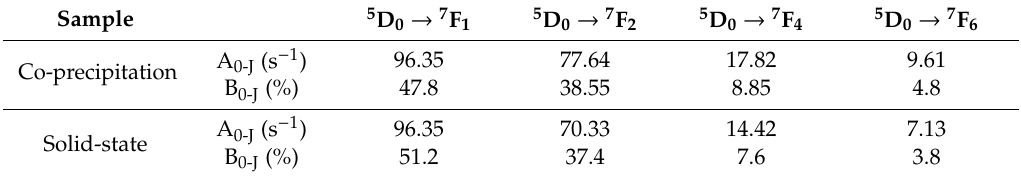
Table 1. The transition rates, branching ratios for 5 D 0 → 7 F J (J = 1, 2, 4, 6) transitions of BMW: Eu 3 + .